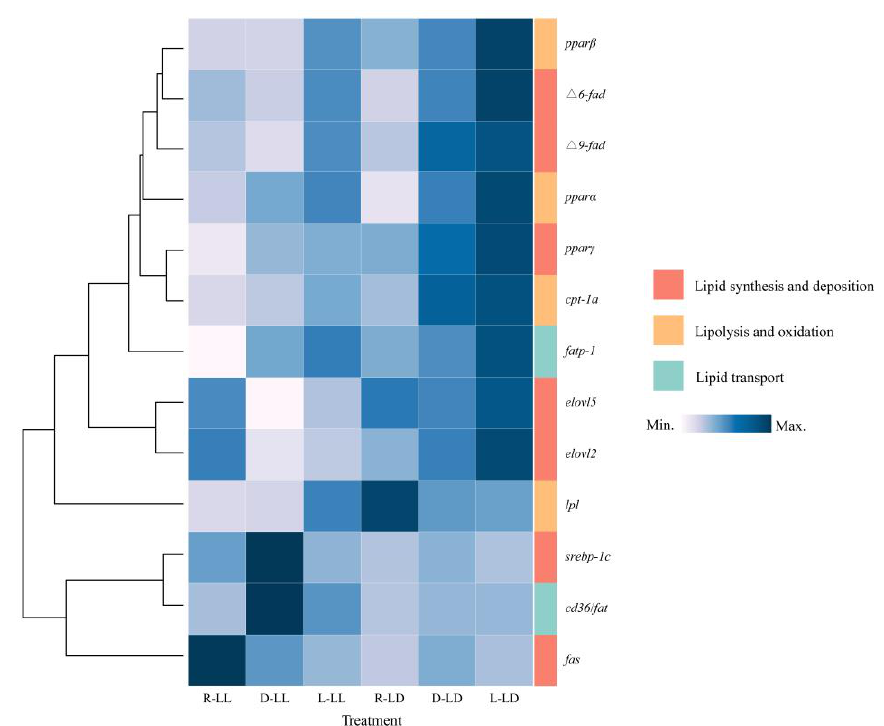
Figure 3. Gene expression of juvenile Oncorhynchus mykiss under different experimental treatments. fas : Fatty acid synthase, ∆ 6-fad : ∆ 6-fatty acid desaturase, ∆ 9-fad : ∆ 9-fatty acid desaturase, elovl2 : Elongation of very long-chain fatty acid protein 2, elovl5 : Elongation of very long-chain fatty acid protein 5, srebp-1c : Sterol regulatory element binding protein 1c, pparα : Peroxisome proliferators- activated receptor α, ppar β : Peroxisome proliferators-activated receptor β , ppar γ : Peroxisome prolif-